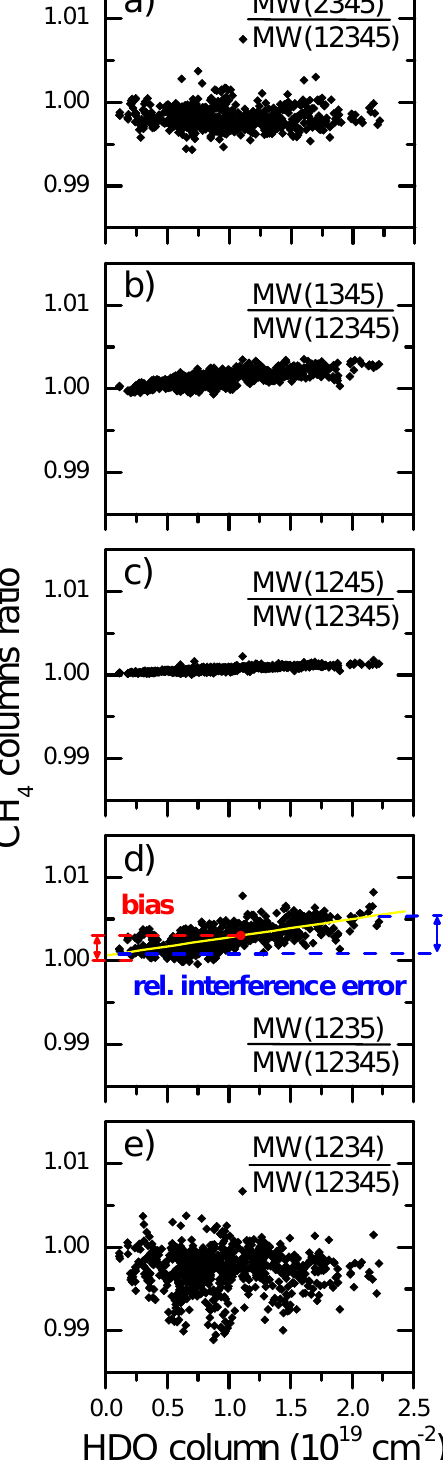
Fig. 8. Ratio of Garmisch year-2007 retrievals of columnar methane with one MW out of 5 dropped (a) – (e) versus retrieval with all 5 MWs plotted as a function of HDO column level. HITRAN 2000 was used in all cases. The definition of total relative interference error and overall bias is